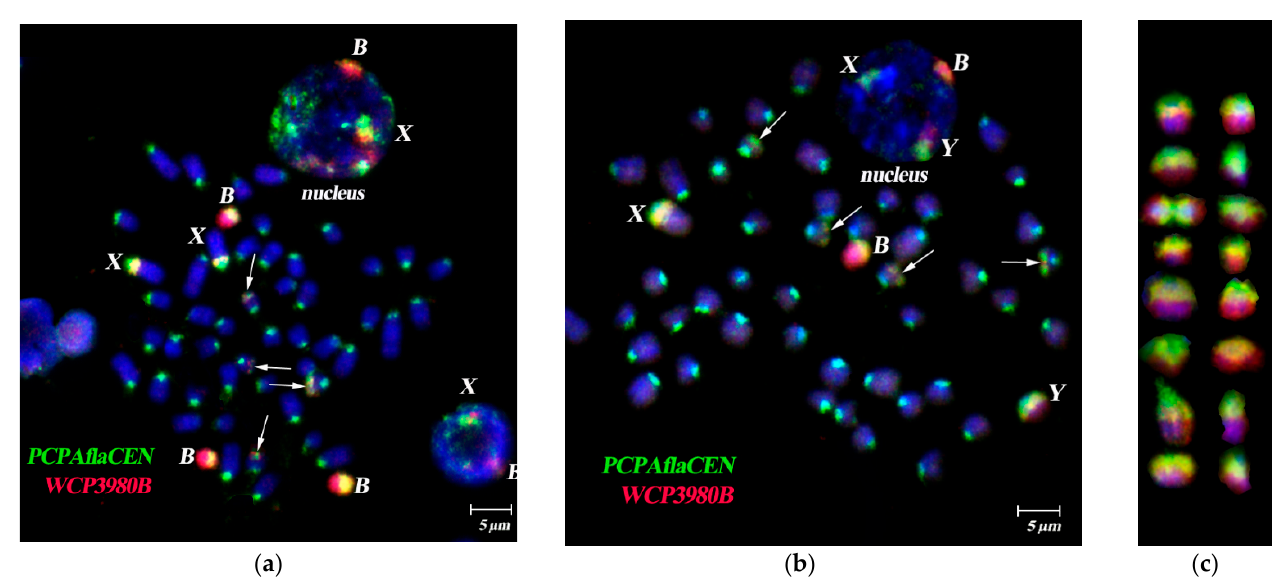
Figure 5. Simultaneous FISH of the B-specific Whole Chromosome Paint (WCP3980B, red signal) and PCPAflaCEN probe, obtained from the pericentromeric region of a large autosome (green signal) on metaphase chromosomes of: ( a ) a female with three Bs (#3854, Misa č a, Serbia); ( b ) male with one B (#24944, Minsk region, Republic of Belarus); ( c ) a gallery of Y chromosomes with FISH signals from different metaphase spreads of four specimens. Every two rows in ( c ) represent a single specimen. Arrows indicate FISH-signals from both probes in subtelomeric regions of two pairs of small chromosomes. Bs, X and Y chromosomes are marked by letters B, X and Y, respectively, on metaphase plates and nuclei. DAPI staining is blue. Scale bar 5 µm.